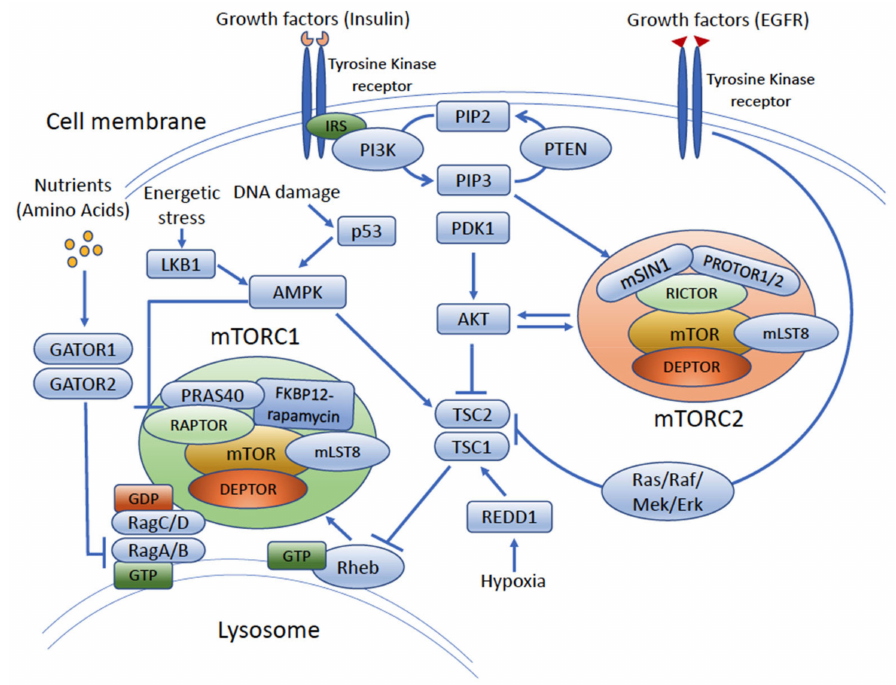
Figure 2. The cellular signaling and regulation of the mTOR pathway . Structurally, mTORC1 and mTORC2 share several protein components, including mTOR kinase, DEPTOR, and mLST8. Each complex also contains a couple of unique proteins. RAPTOR and PRSA40 are the components of mTORC1, where RICTOR and mSIN1 are the subunits of mTORC2. Both complexes integrate extracellular signaling through upstream PI3K/AKT and Ras/Raf/Mek/Erk signaling pathways to guide their own activation. mTORC1 is also regulated by the cellular status of amino acids,